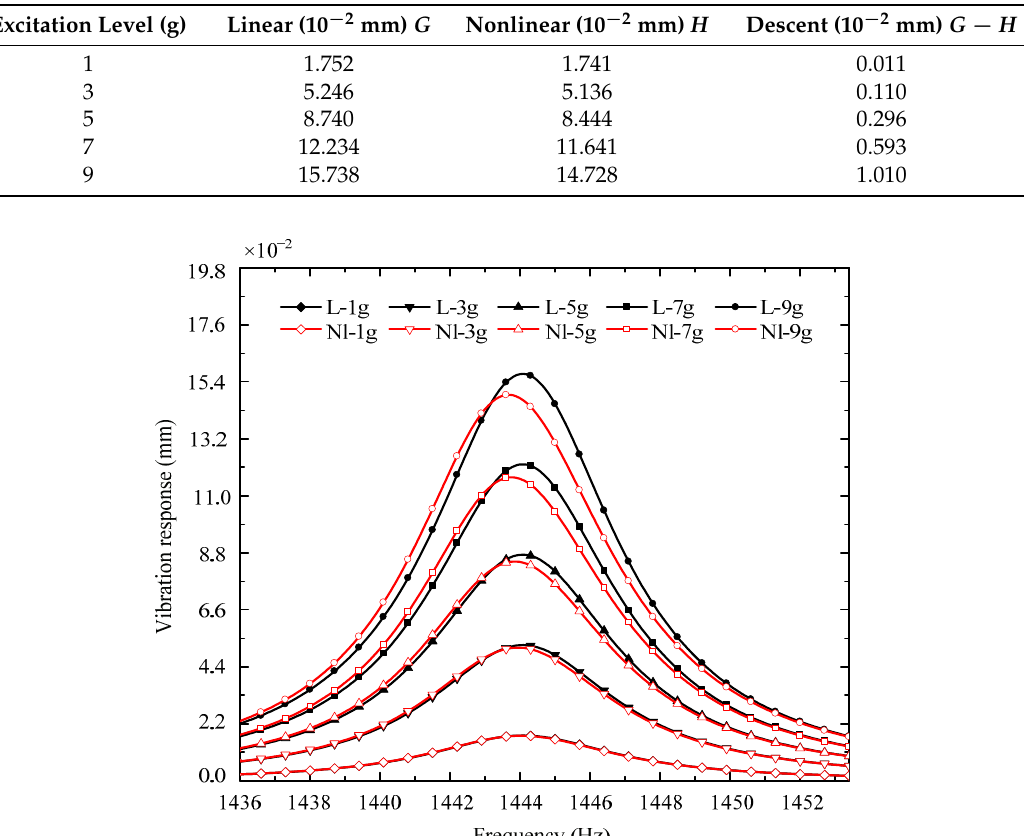
Table 8. The 3 order linear and nonlinear resonant responses of the hard-coating cylindrical shell under different excitation levels.